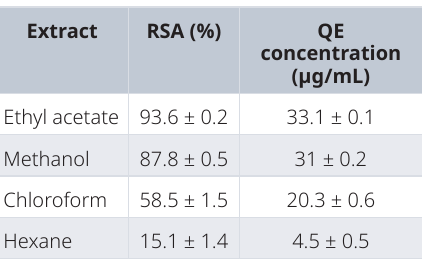
Table 2. Zone of inhibition (mm) of V. pinnata extracts.